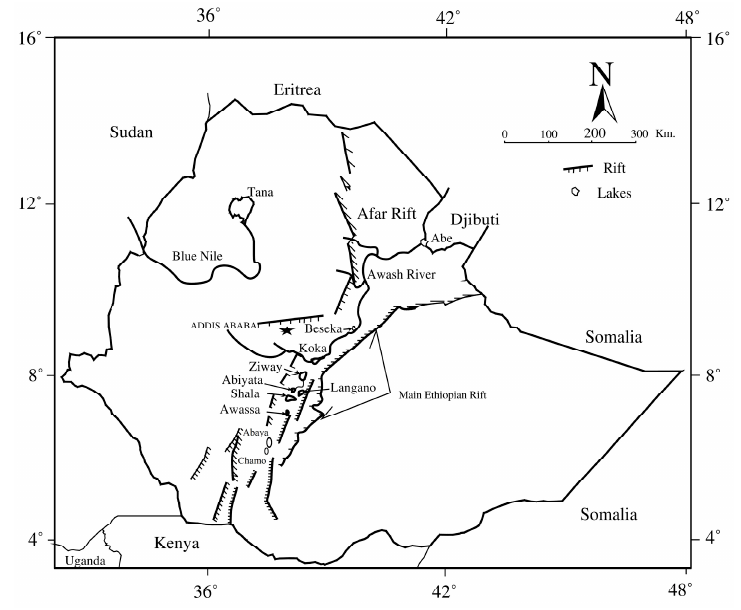
Figure 1. Relative locations of the Ethiopian rift-valley lakes (source: Alemayehu et al. [13]). (N.B: The original map does not show Lake Abaya and Chamo).